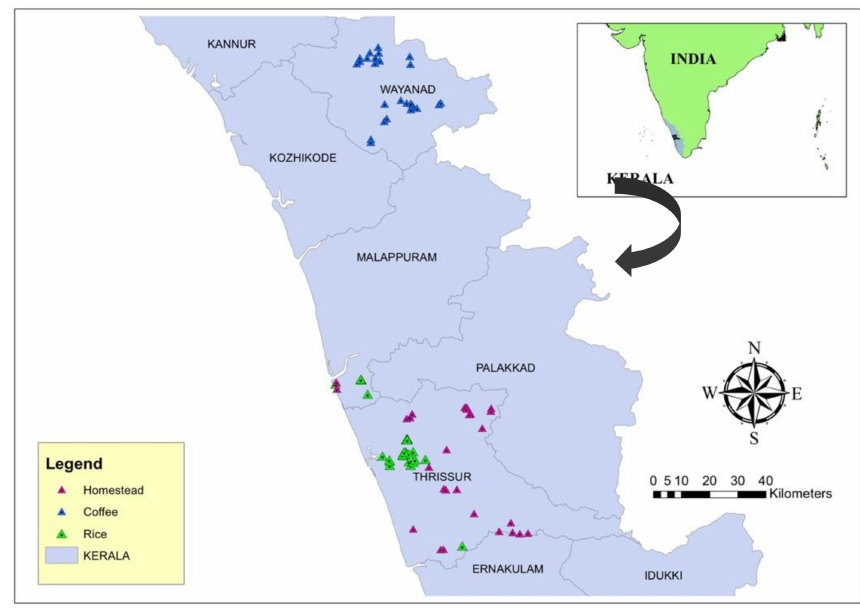
Figure 1. Locations of farmer